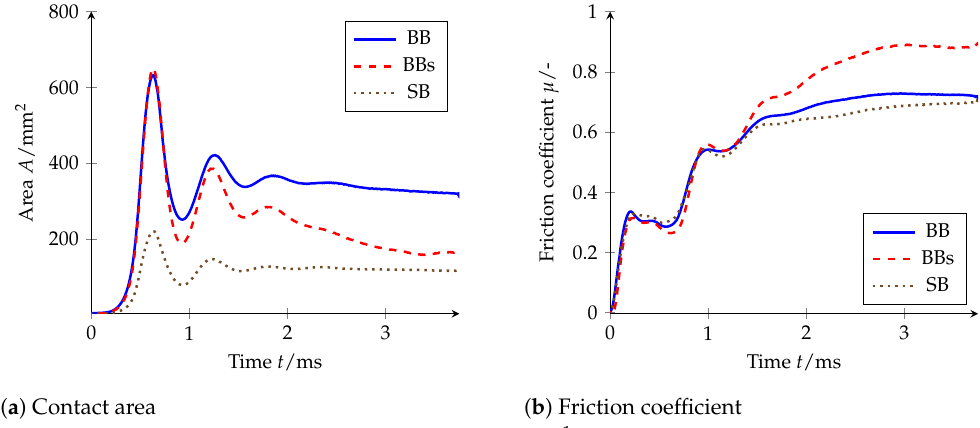
Figure 21. Simulation results for pattern BB at 140kmh − 1 and the parameters described in Table